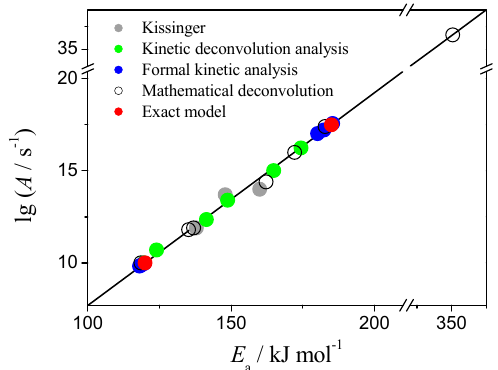
ff ect on the kinetic parameters calculated for Case 1 Figure 6. Kinetic compensation effect on the kinetic parameters calculated for Case 1 data. Figure 6. Kinetic compensation e